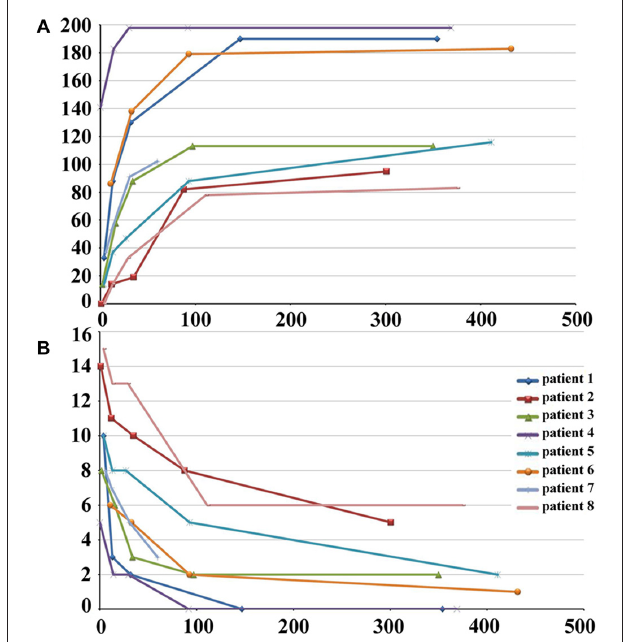
FIGURE 2 | Post-stroke recovery curves of stroke patients . The x -axis denotes days after stroke onset; y -axis denotes MI (A) and NIHSS scores (B) . MI, Motricity Index; NIHSS, National Institutes of Health Stroke